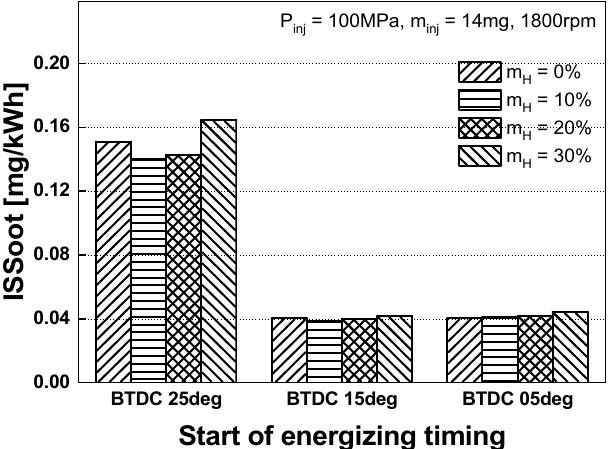
Figure 10. Effect of water vapor portion on the indicated specific soot (ISSoot) characteristics under different start of energizing timing (P inj = 100 MPa, m inj = 14 mg, 1800 rpm).